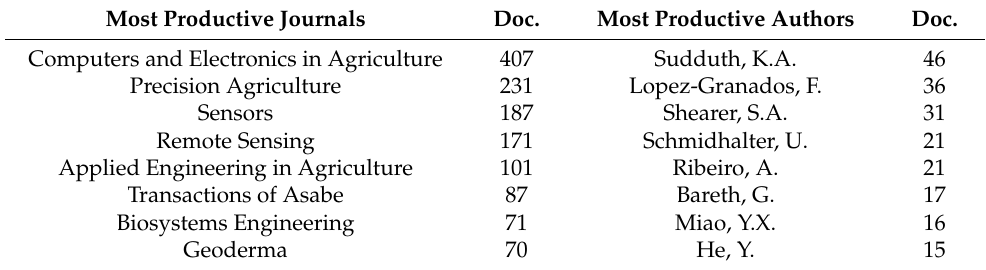
Figure 5. Thematic evolution structure. Table 3. Most productive journals and authors. It should be stressed that this list is just for guid- ance purposes and does not take into account the type of papers published (original article versus